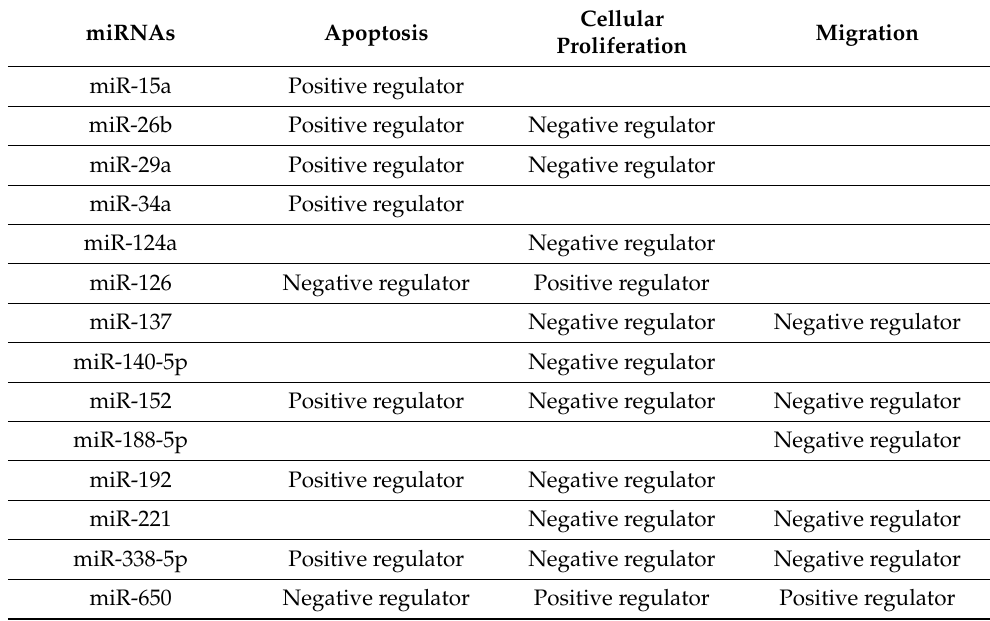
Table 6. Role of microRNAs (miRNAs) in synovial hyperplasia in rheumatoid arthritis (RA) [8,87]. miRNAs Apoptosis